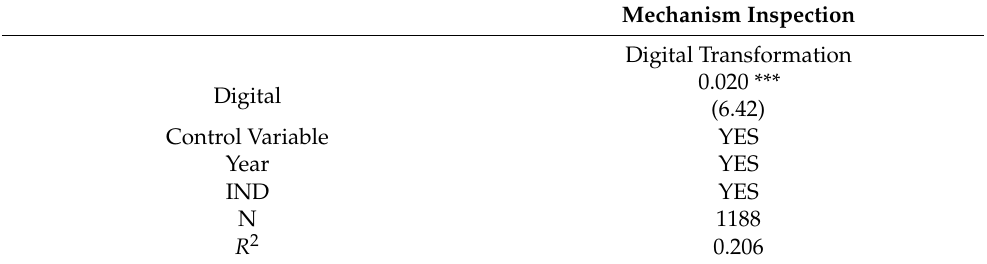
Table 6. Mechanism test